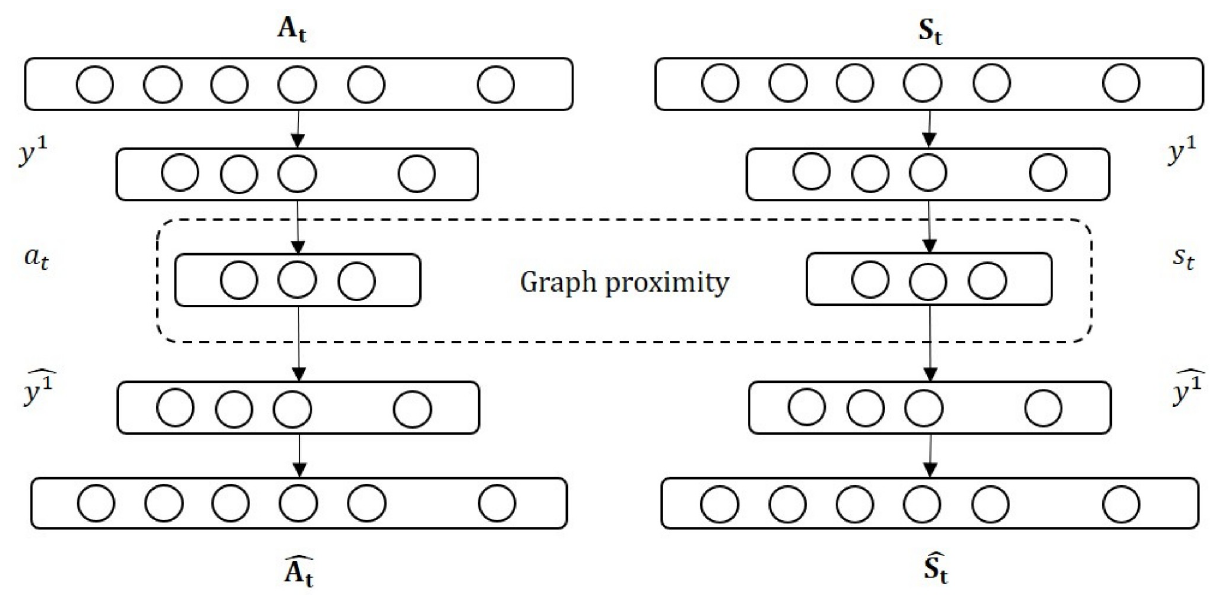
Fig 4. Architecture of DynGPE